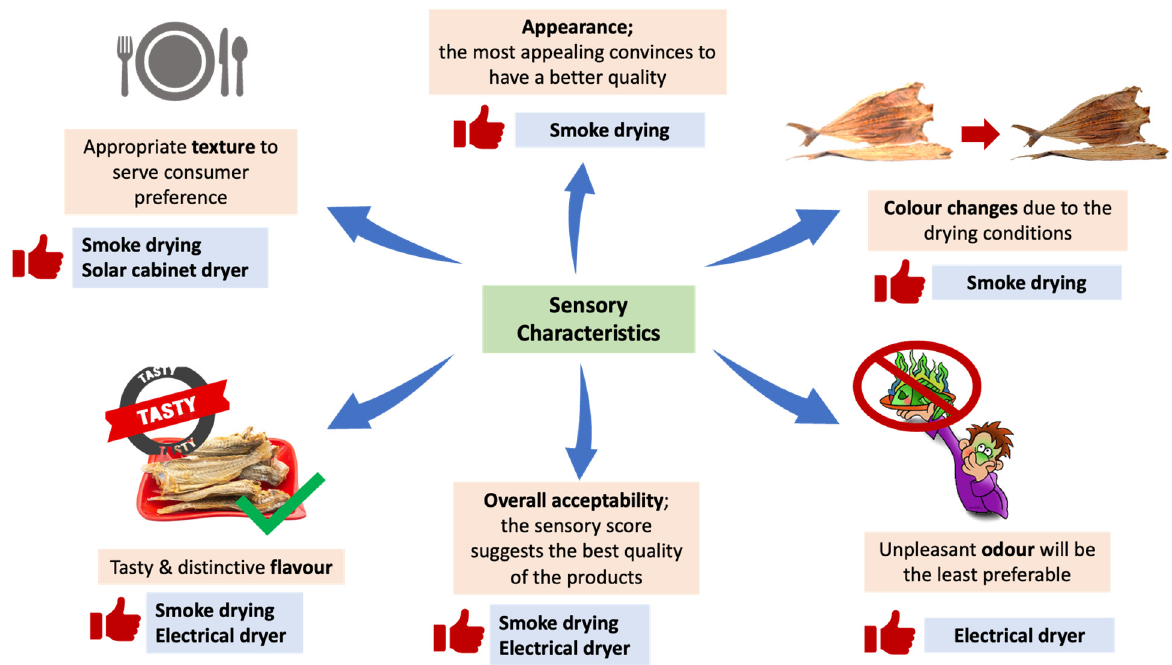
Figure 5. Sensory characteristics of dried fish with preferable parameters.